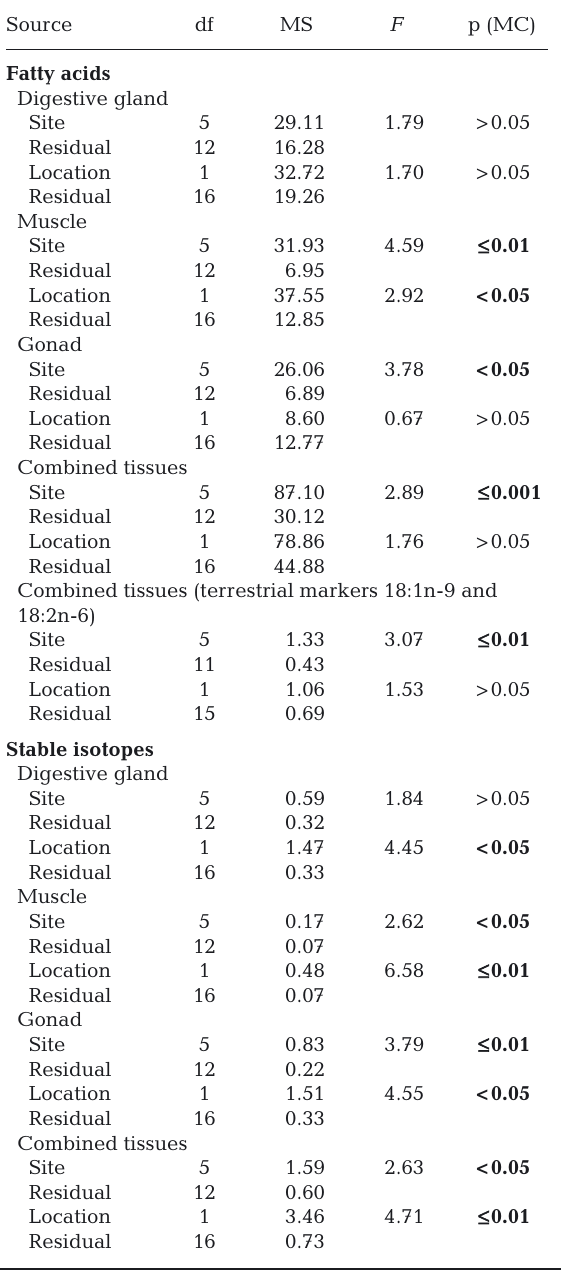
Table 5. PERMANOVA of the differences between sample site and location for the full fatty acid profile and stable isotopes